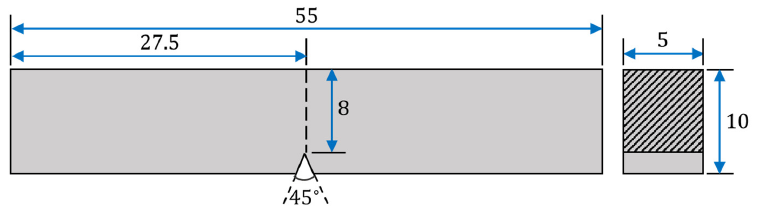
Figure 2. Geometry and dimensions of the low-temperature impact test specimens (unit: mm).